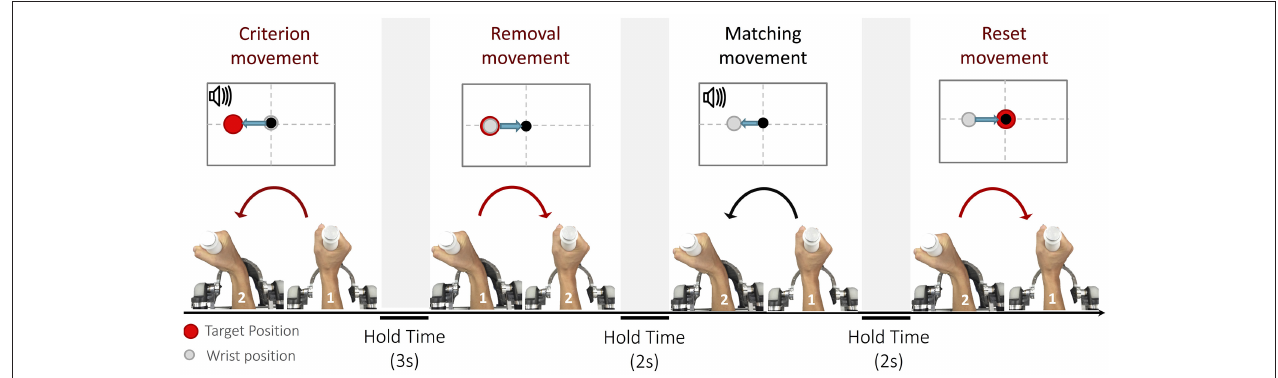
FIGURE 2 | The Joint Position Matching task: Each trial is broken down into four parts: (1) criterion movement toward the proprioceptive target, (2) removal movement from the proprioceptive target, (3) matching movement, (4) and reset movement to the neutral position. Depending on the loading condition, the four movements can be performed either actively or